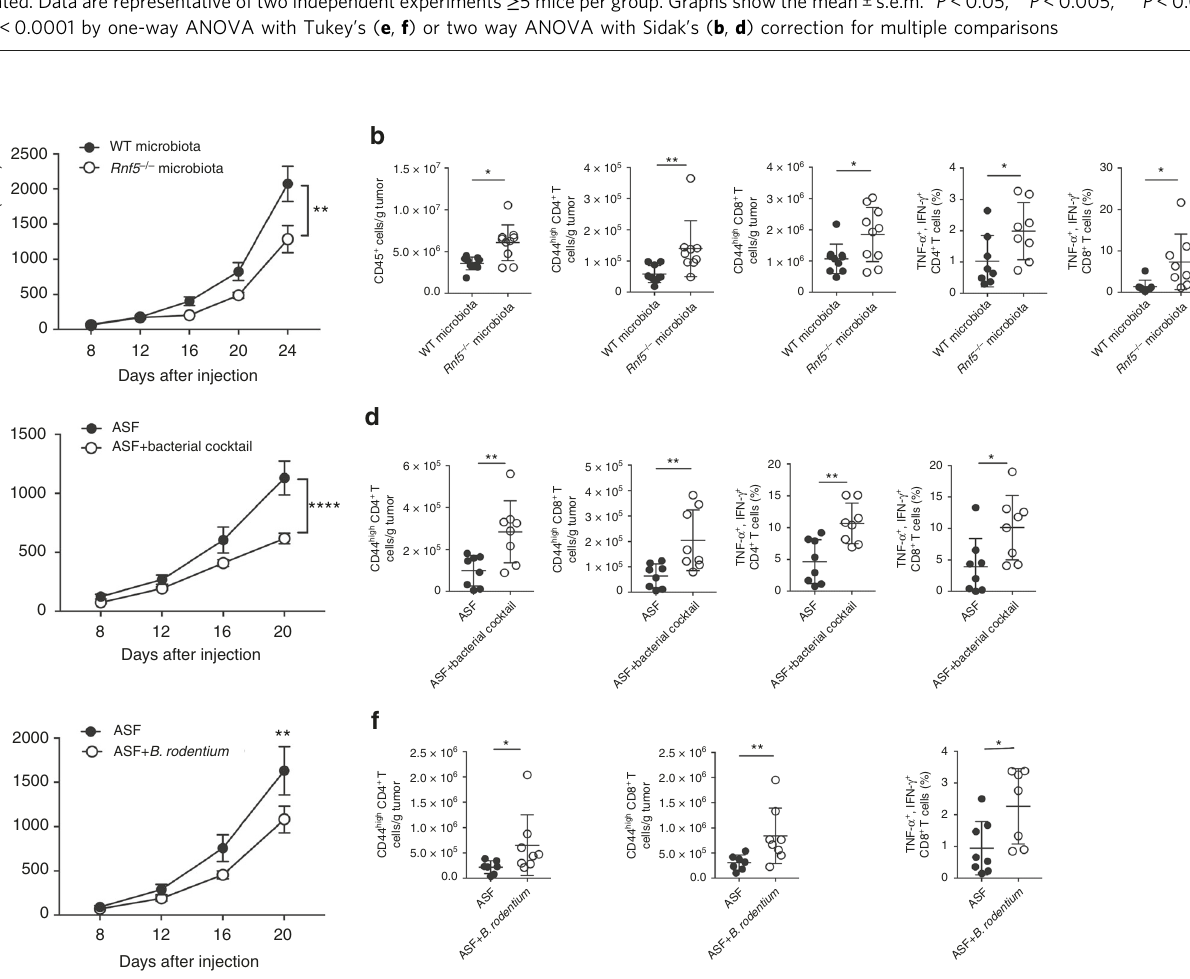
indicated. Data are representative of two independent experiments ≥ 5 mice per group. Graphs show the mean ± s.e.m. * P < 0.05, ** P < 0.005, *** P < 0.001,